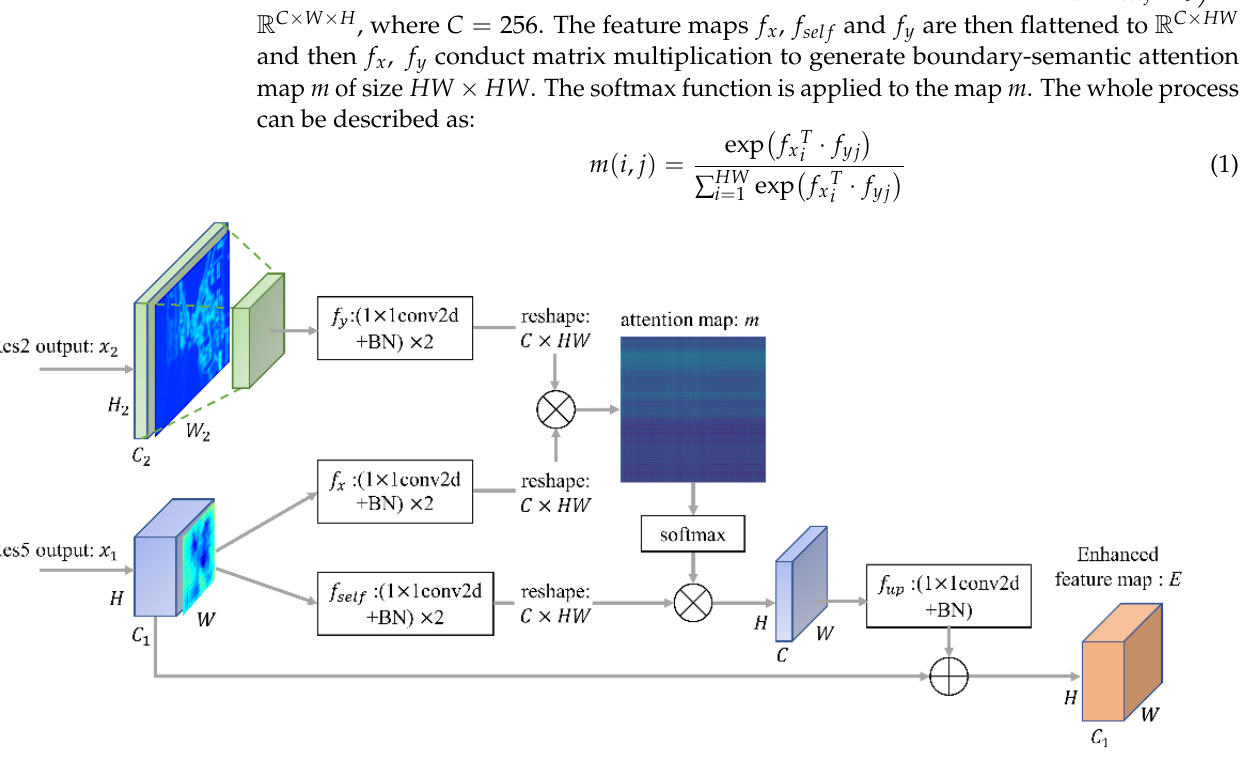
Figure 2. The overall architecture of our proposed Context Feature Enhanced (CFE)